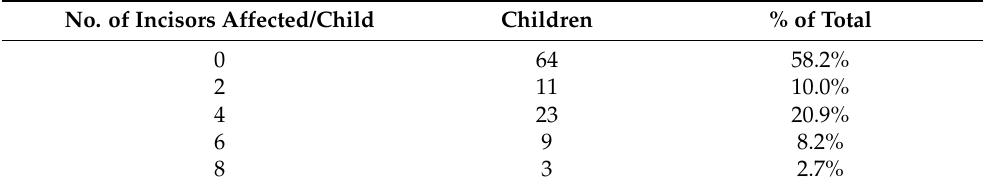
Table 2. Frequencies of the number of temporary incisors affected for every child.